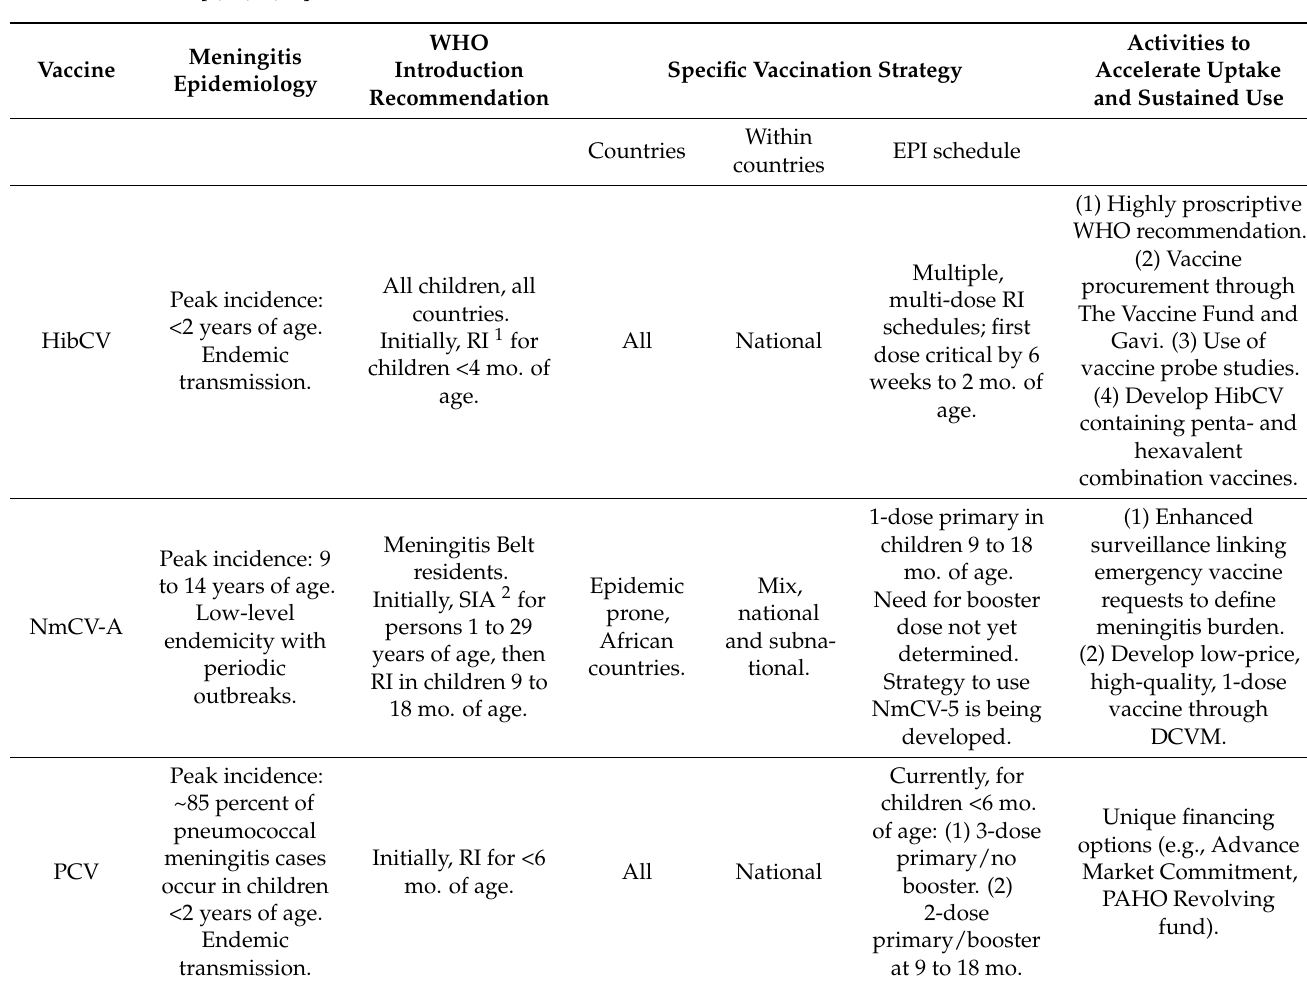
Table 5. Introducing polysaccharide conjugate vaccines to prevent meningitis due to Hib, meningococcus, and pneumococ- cus in LMICs